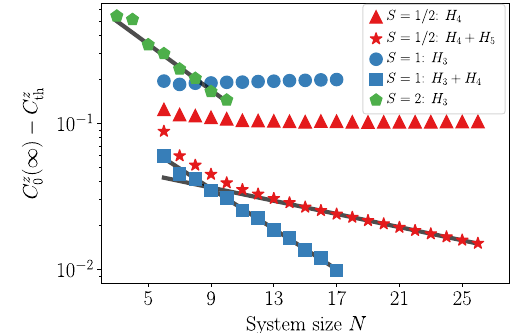
FIG. 4. Saturation value of the autocorrelator. Finite-size study of the lower bound in Eq. (4) for the time-averaged correlation function C z 0 ð t Þ as a function of the system size. We have 2 (cid:2) = ½ð 2 S þ 1 Þ N (cid:2) ≡ ð 1 =N Þ tr ½ð S z substracted the thermal value C z 0 Þ th for a general spin S and a chain of length N . For the minimal spin-1 model H 3 (blue dots), the lower bound is slightly increasing with the system size. On the other hand, it decays to zero exponentially for the combined Hamiltonian H 3 þ H 4 (blue squares). For comparison, we also show results for other local spin S : The larger the on-site Hilbert space dimension, the easier it is for the system to thermalize [92].